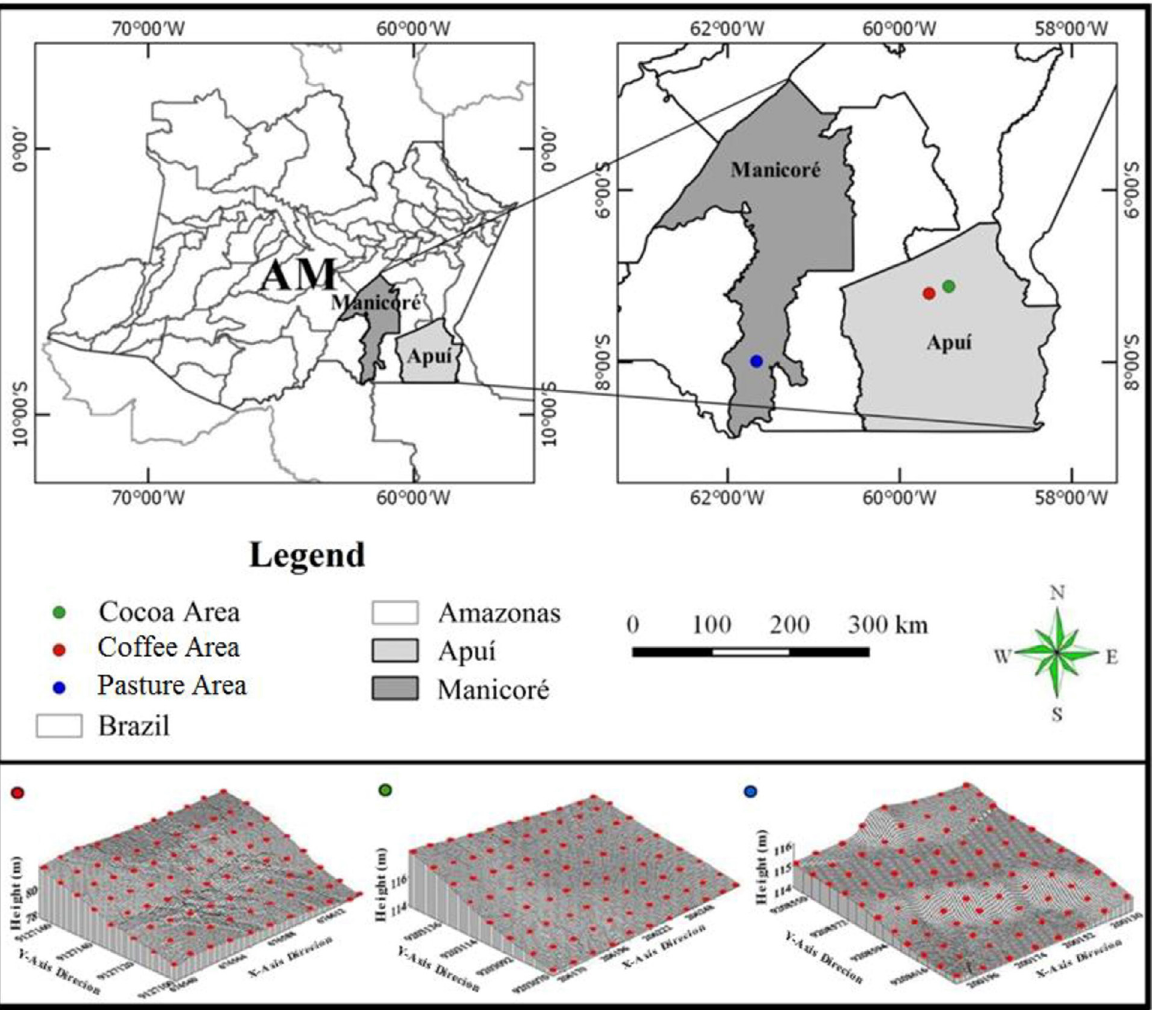
Figure 1. Location map and digital elevation model of the studied areas in southern Amazonas State,